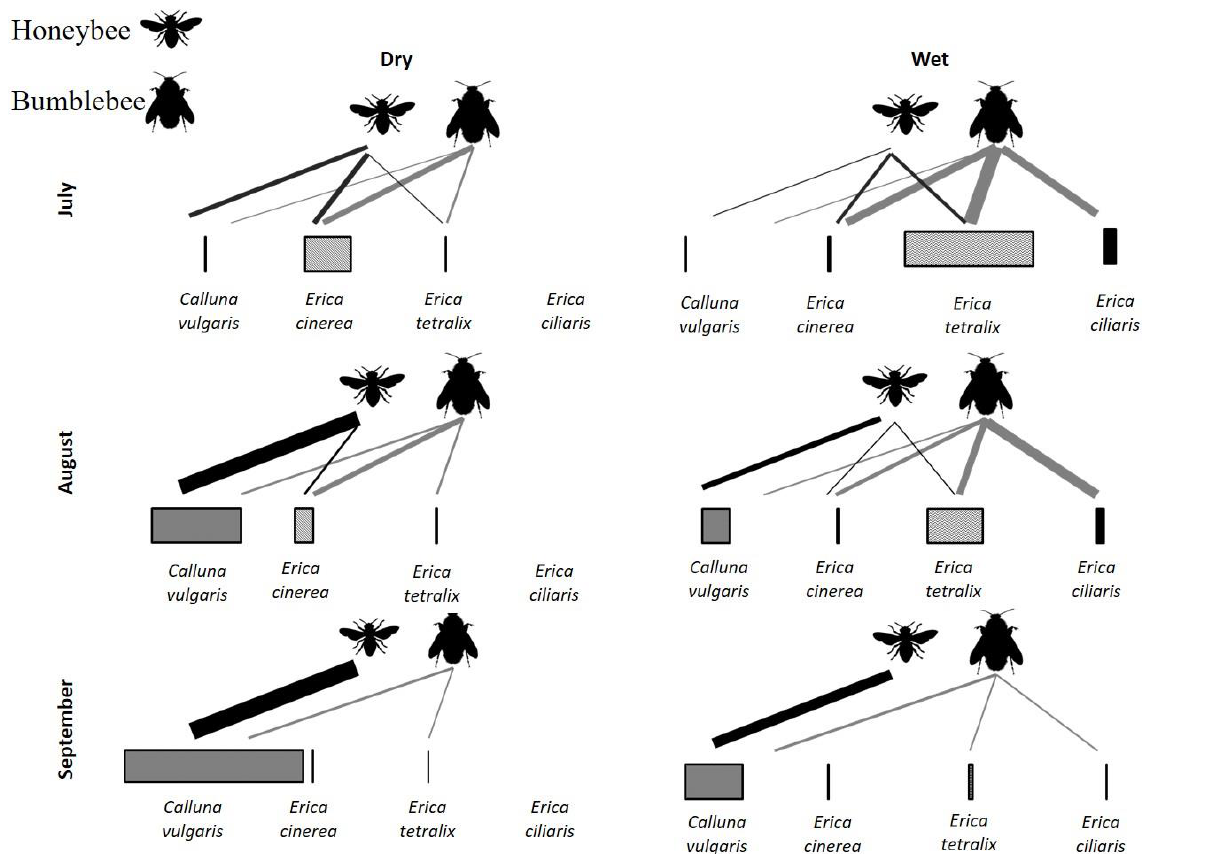
F IGURE 3. Relative mean forage availability (% cover) of each heather species on dry and wet heath types and mean forager observations on each heather species. Boxes are to the same scale with 1 unit representing 1% floral cover. Lines are to the same scale with each unit representing forager observation honey bees in black and bumble bees in